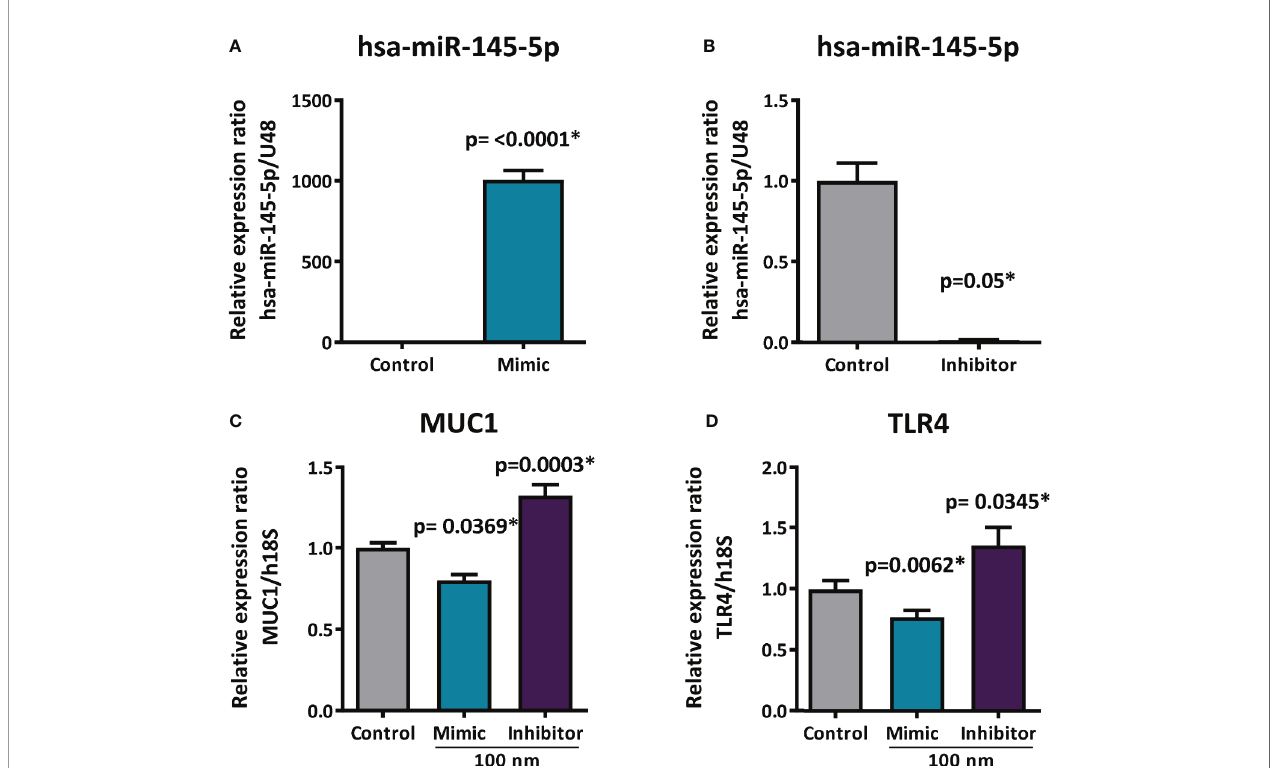
FIGURE 7 | Expression of MUC1 and TLR4 after hsa-miR-145-5p overexpression or inhibition. (A) Increased hsa-miR-145-5p levels in HSG cells transfected with the mimic miRNA. (B) Decreased hsa-miR-145-5p levels in HSG cells transfected with inhibitor miRNA. (C) Relative expression ratio of MUC1 transcripts in HSG cells transfected with mimic hsa-miR-145-5p or inhibitor (D) Relative expression ratio of TLR4 transcripts in HSG cells transfected with mimic hsa-miR-145-5p or inhibitor. Data are representative of at least three independent experiments. (*) p-value ≤ 0.05 was considered signi fi